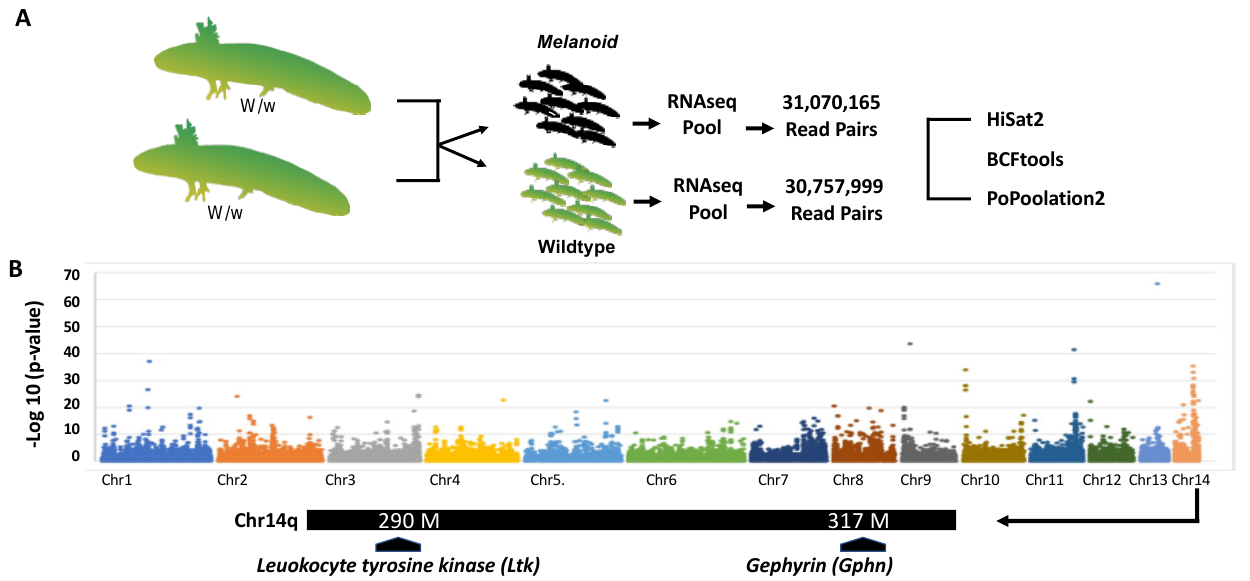
Figure 3. Overview of the bulk segregant RNA-Seq approach used to identify candidate genes for melanoid . ( A ) RNA was isolated for wild-type and melanoid siblings, and >30 m read pairs were generated for each pool. Sequences were aligned to the axolotl genome and used to identify a region of Chr14q that was differentially enriched for SNPs between the pools. ( B ) Map of a Chr14q genomic region showing the positions of Ltk and Gphn . There are at least 70 predicted genes within the interval defined by these two genes.